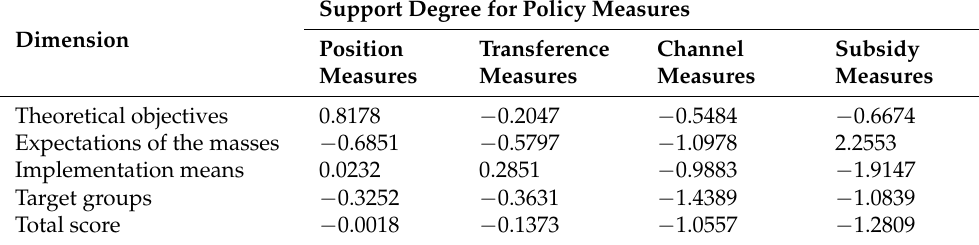
Table 14. Support degree for policy